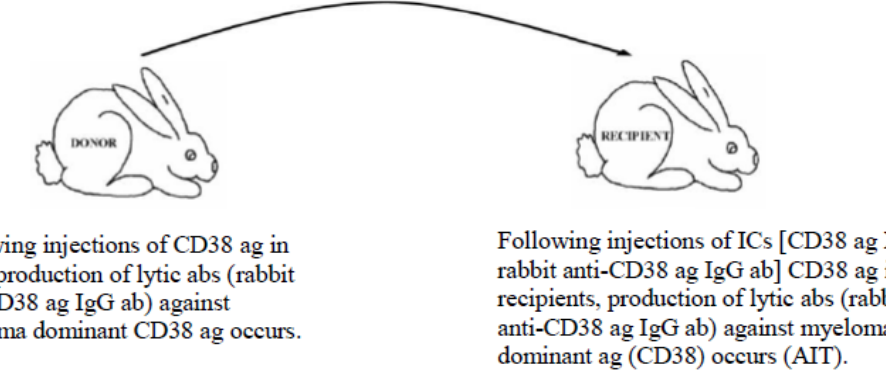
Figure 3. AIT by initiating/maintaining lytic ab response against CD38 cancer specific ag. Recipient rabbits produced the same class of ab with the same specificity against the target ag as present in the inoculum, namely rabbit anti-CD38 ag lytic IgG abs that was able to lyse (eliminate) cancer cells in vitro and in vivo in a complement fixation test. Abbreviations: ab, antibody; ag, antigen; AIT, antibody information transfer; CD38, cancer specific antigen; FCA, Freund’s complete adjuvant; IgG, immunoglobulin G.